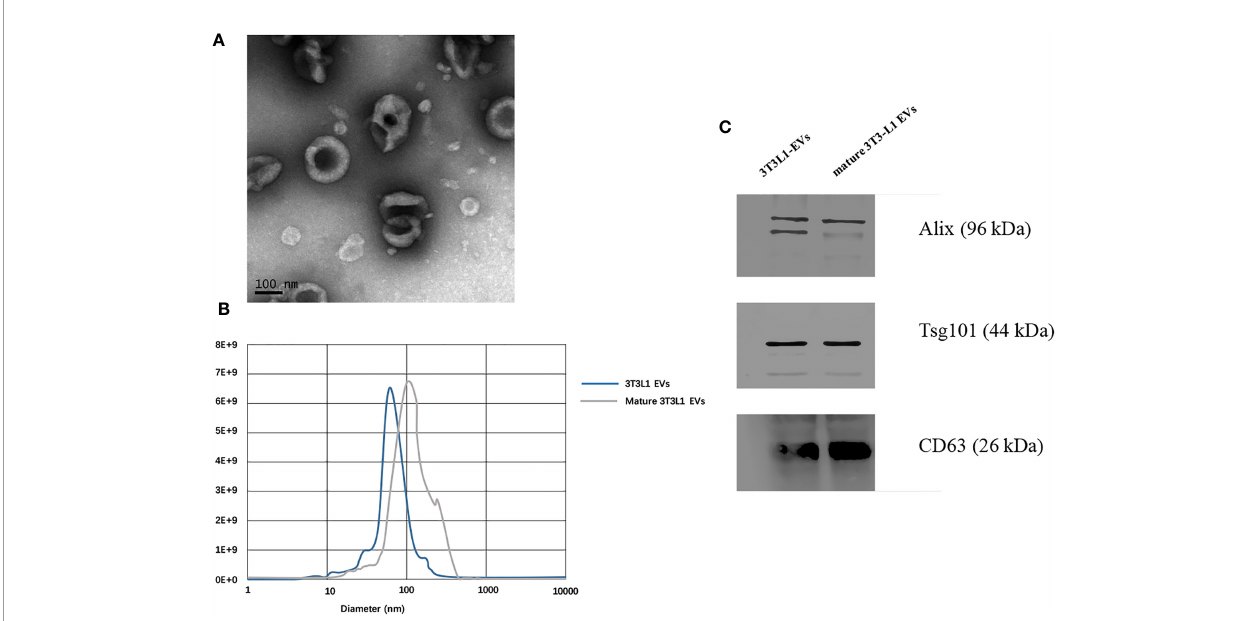
FIGURE 2 | Identi fi cation of adipocytes derived extracellular vesicles. (A) Transmission electron microscope observation of whole-mounted puri fi ed extracellular vesicles derived from adipocytes. (B) Nanoparticle tracking analysis for particles size distribution of extracellular vesicles derived from pre-adipocytes/mature adipocytes. (C) Detection of CD63, Alix, and Tsg101 expression in extracellular vesicles derived from pre-adipocytes/mature adipocytes by Western